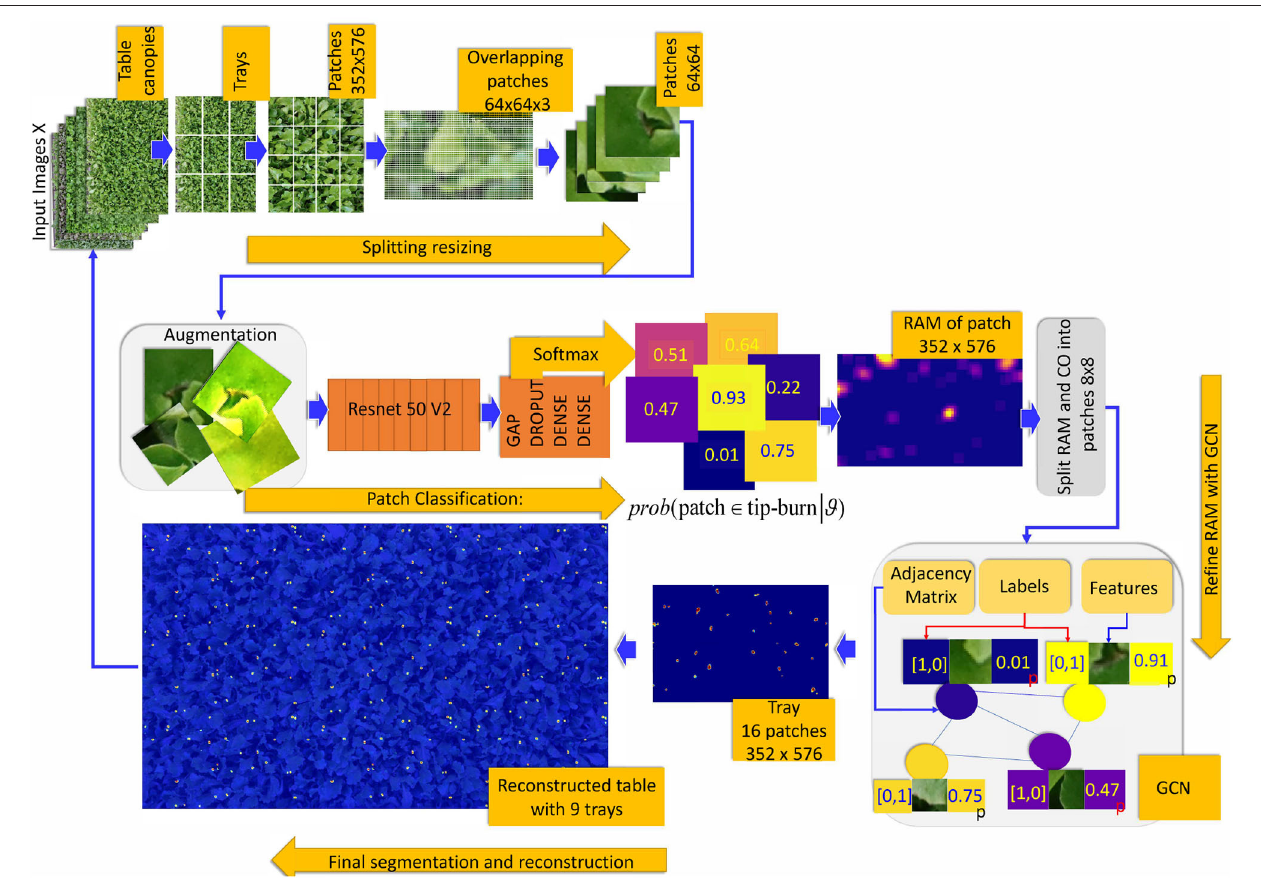
FIGURE 6 | Overview of the weakly supervised semantic segmentation process of tip-burn leaves stress supervised with image-level class annotation only. Above, the splitting process starts at images X ∈ R M × N × 3 , M = 4,640, N = 6,960. Note that starting from patches of size 352 × 576 × 3 the splitting process plays with overlapping patches of size 64 × 64 × 3 with a hard stride of 8 pixels. The classification is trained to detect tip-burn stresses, and via the softmax to predict a probability for each patch to belong to the class tip-burn. After classification, a reconstruction step obtains the Reconstructed Attention Map (RAM) for patches of size 352 × 576 × 3. These are again split into patches 8 × 8 × 3 and used to supervise the Graph Convolutional network (GCN). Namely, the GCN features nodes are the flattened 8 × 8 × 3 patches and the labels are one hot encoded vectors obtained from the classification predictions, see the plate with the GCN, The GCN estimates a refined semantic segmentation of pixels. A final reconstruction does the inverse splitting process reconstructing the table canopies from